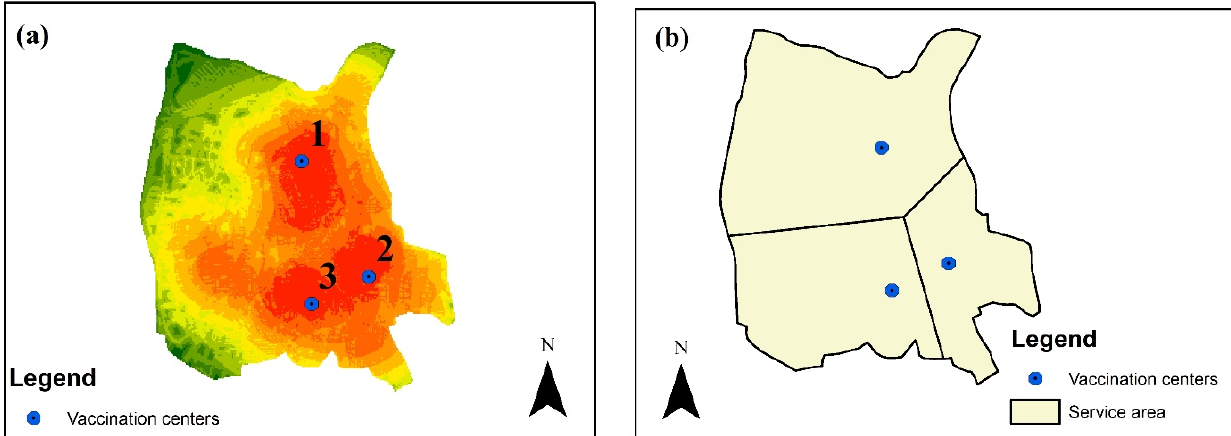
Figure 7. Suitability map for the vaccination centres ( a ) assigned vaccination centres ( b ) service areas of vaccination centres. Sensitivity analysis was applied to measure the effects of the criteria on vaccination centre locations. Six different scenarios were created by changing the criterion weights. In all scenarios, the sum of criterion weights is one.